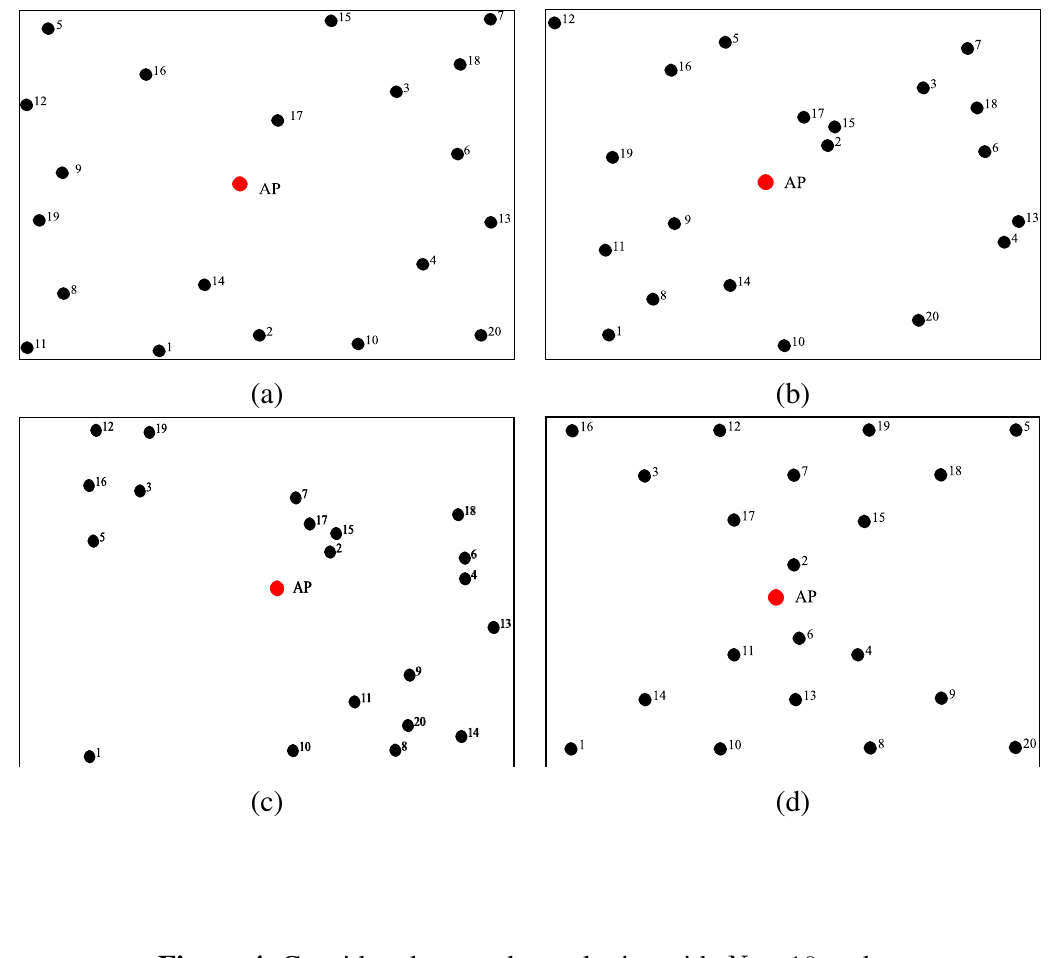
Figure 4. Considered network topologies with N = 10